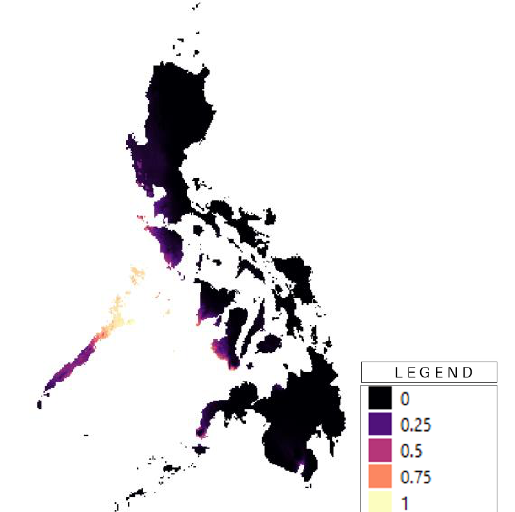
Figure 2. Visualized prediction of Maxent for V. palawanensis The sensitivity VS specificity graph together with the area under the curve (AUC) is shown below. The high AUC shows that the model can predict the presence or occurrence with good accuracy